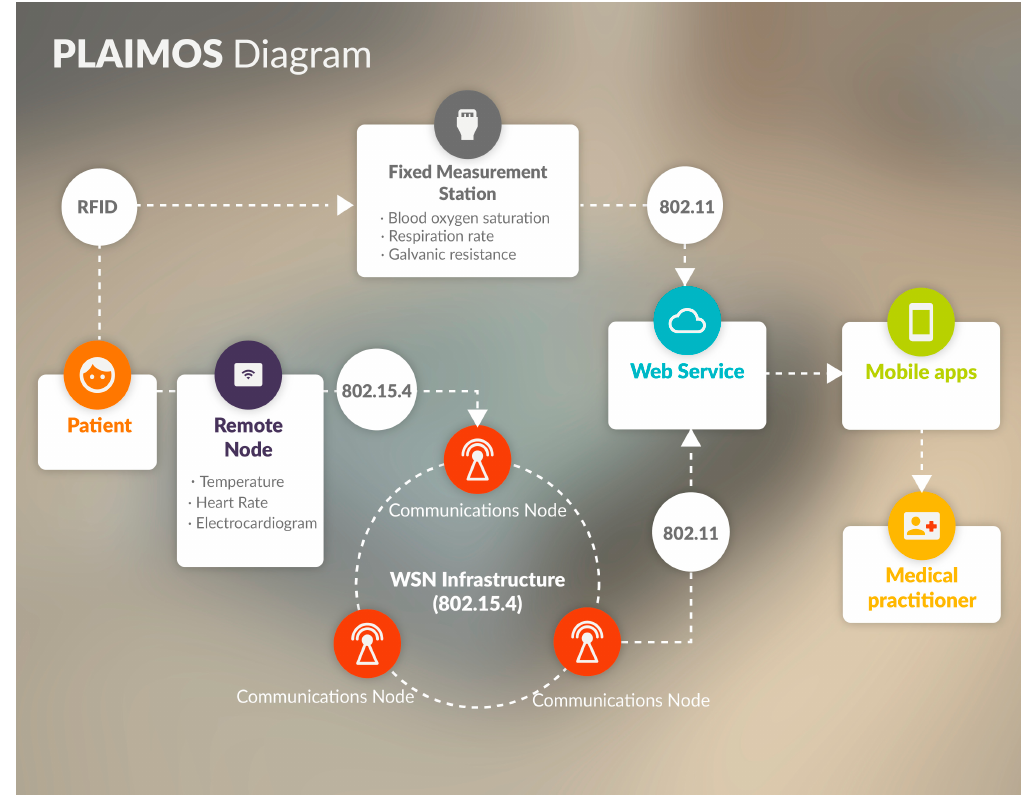
Figure 1. PlaIMoS platform architecture.